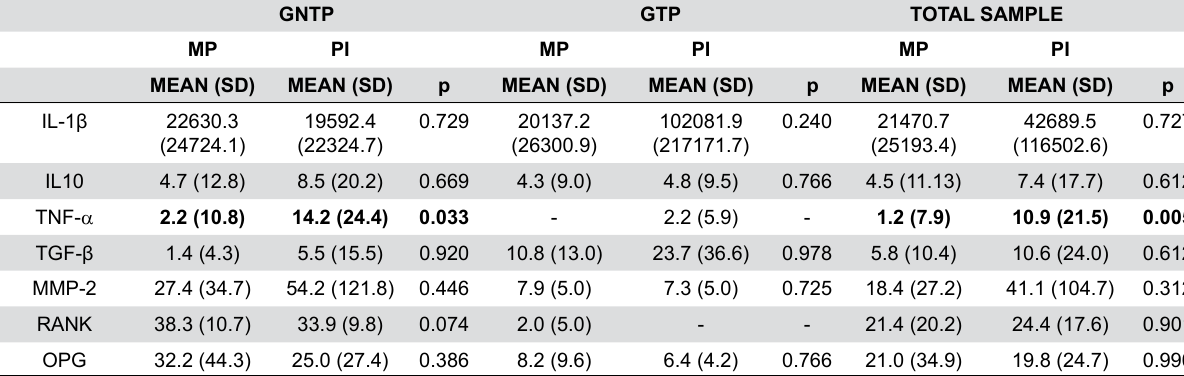
Table 2- Comparison of biomarker concentrations (pg/ml) in GNTP and GTP groups related to clinical diagnose at final